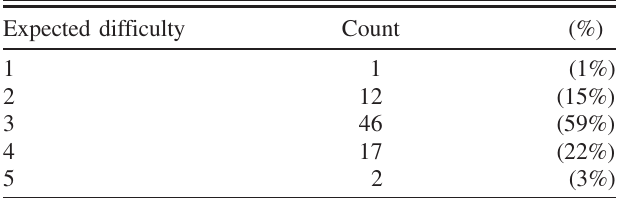
TABLE II. Students ’ precourse expectations about the diffi- culty of the course. Here, 1 means extremely easy and 5 means extremely difficult.